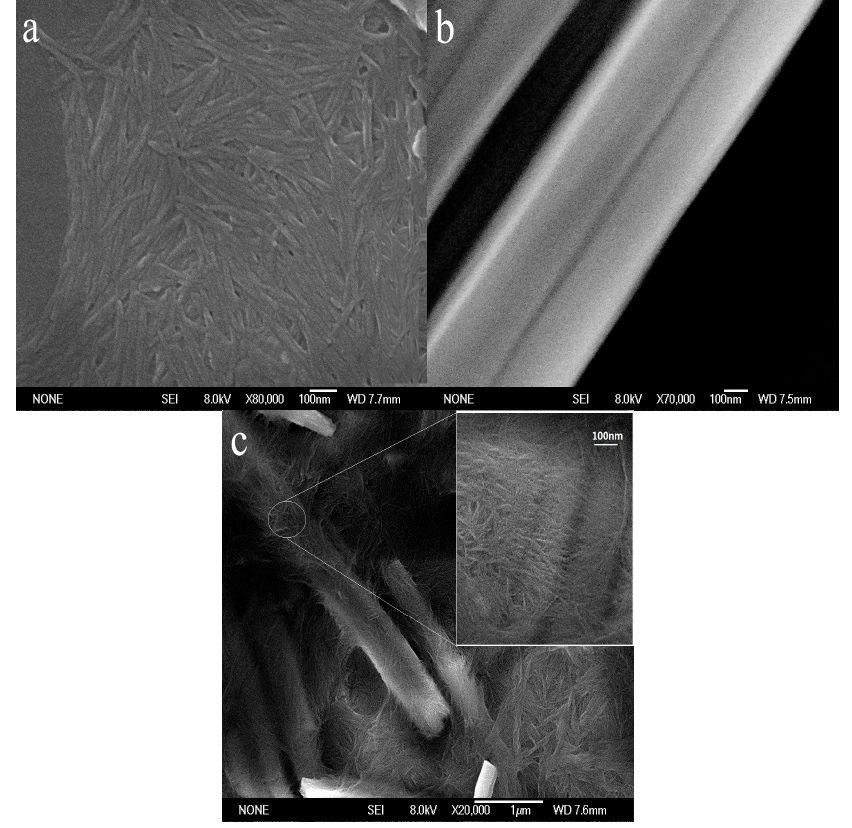
Figure 1. The SEM of ( a ) ChW; ( b ) PTW; and ( c ) ChW-PTW.